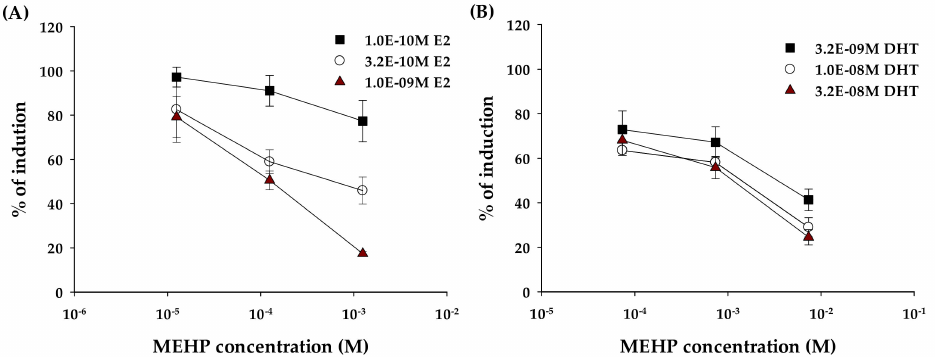
Figure 4. The antagonistic e ff ects of MEHP according to the di ff erent concentrations of estrogenic ( A ) and androgenic ( B ) activity,